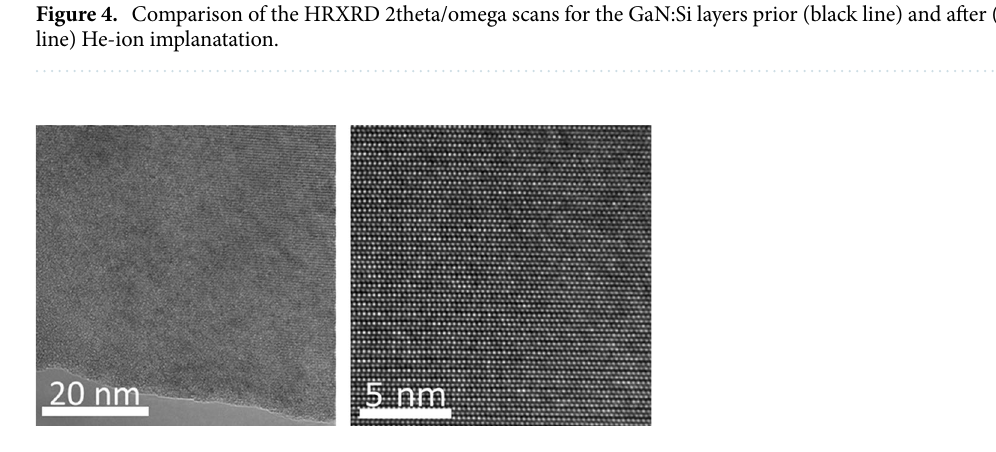
Figure 5. STEM images of GaN:Si layer after helium ions implantation with different scale. No extended defects was